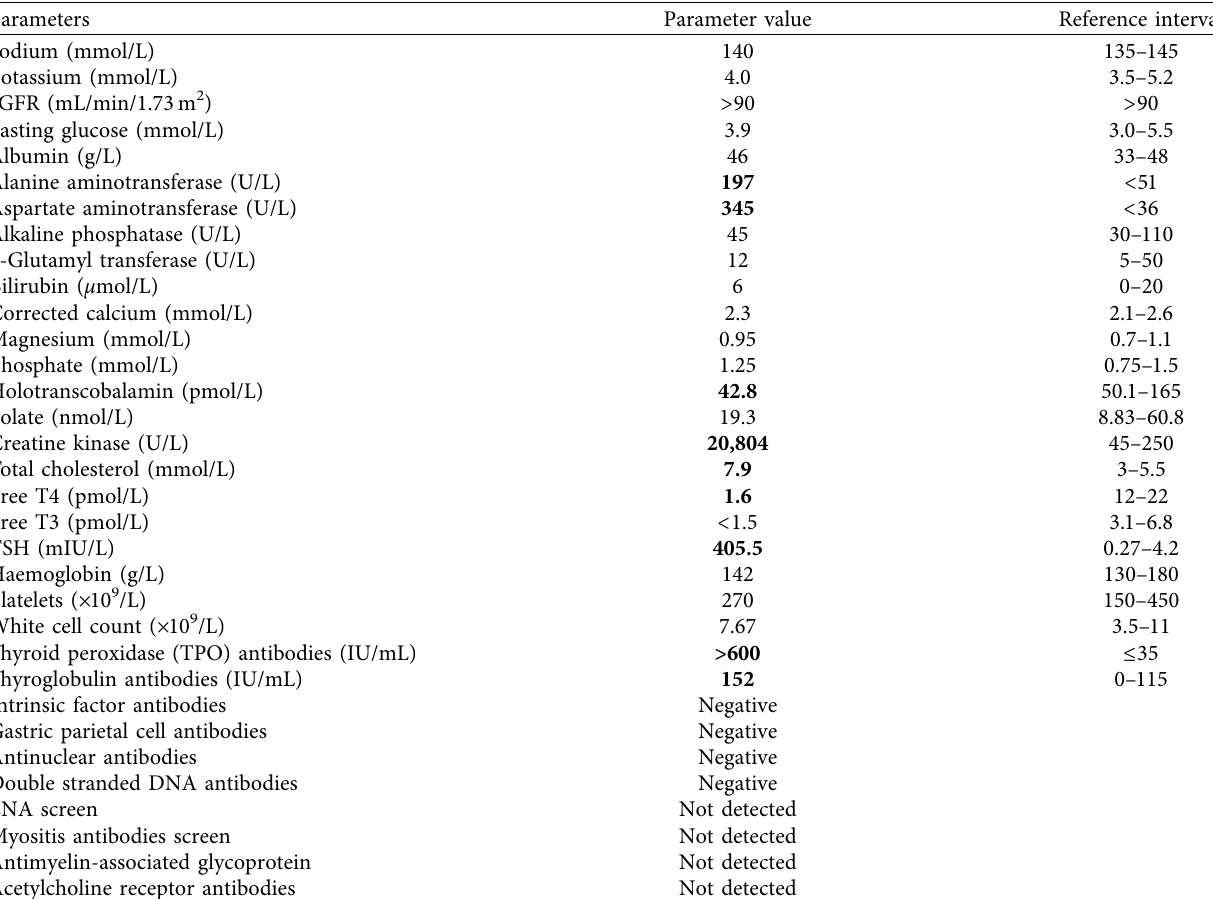
Table 1: Results of initial laboratory tests (September 2019).